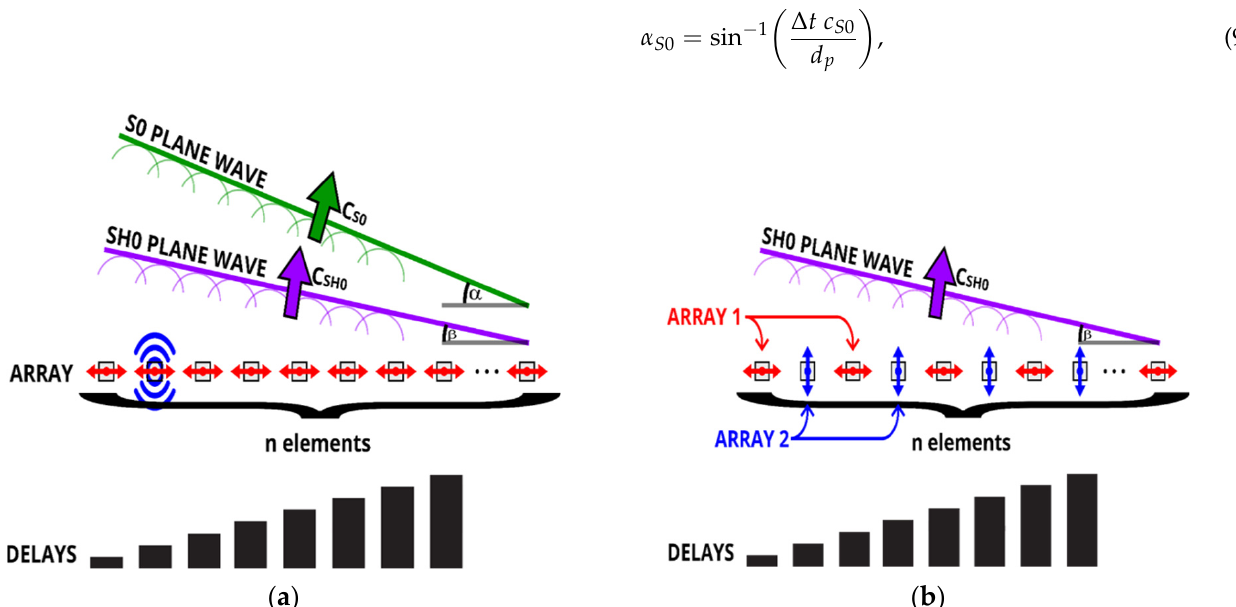
Figure 4. SH0 guided wave mode plane wave excitation using ( a ) classic transduction setup, and ( b ) S0 mode cancelling transduction setup.